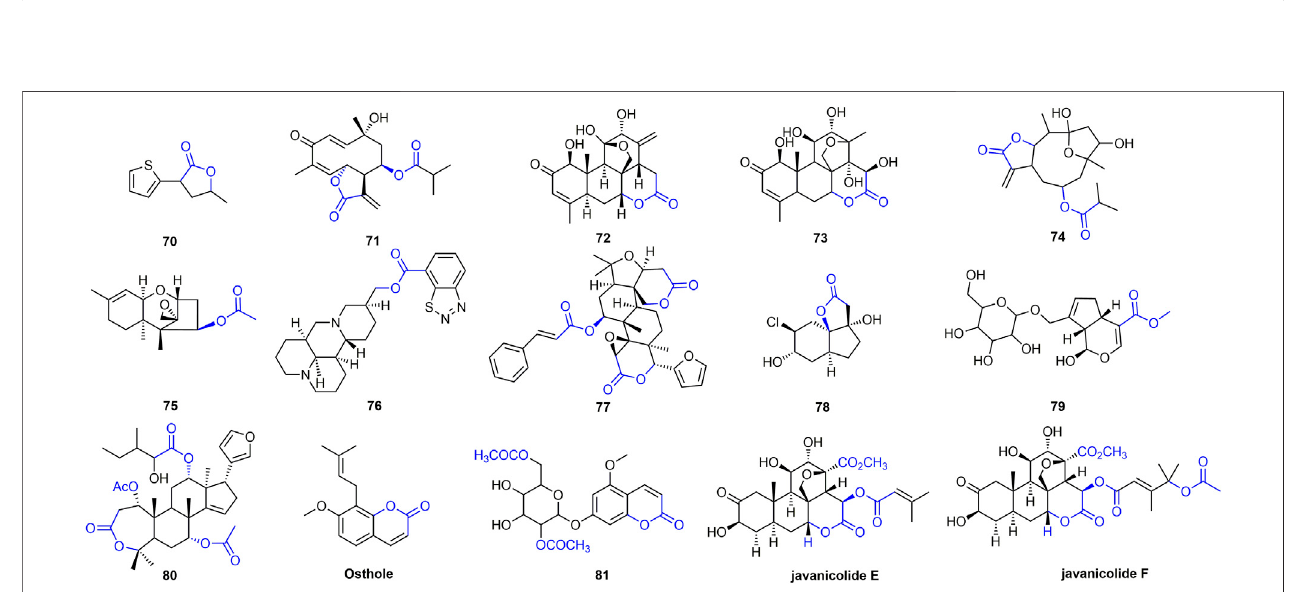
FIGURE 13 | Structures of representative purine nucleoside derivatives in antiviral activities.